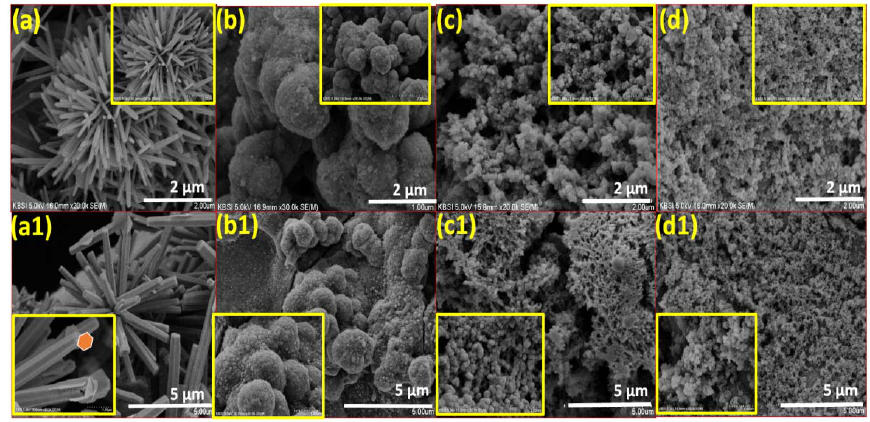
Figure 1. Field emission scanning electron microscopy images of ( a ) ZnO ( b ) ZnO/NiS ( c ) ZnO/NiS/PEDOT:PSS ( d ) ZnO/NiS/PEDOT:PSS/MnO 2 and their corresponding high magnification images (a1, b1, c1 and d1).